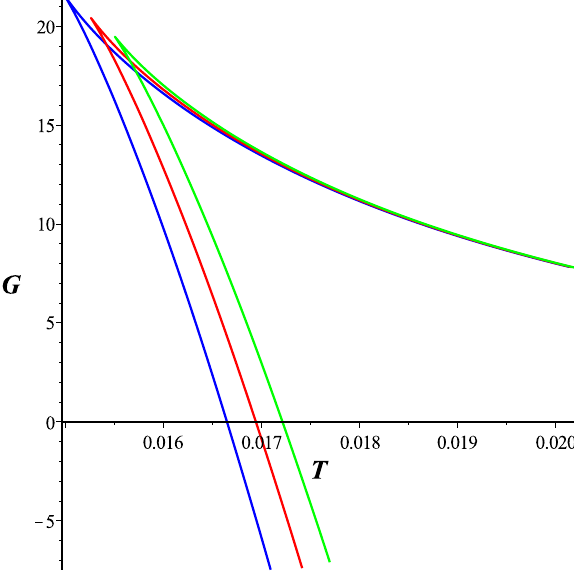
Fig. 1 HP phase transitions for n = 3, d = 10 and Q = 1, p = 0 . 0000045 (blue), p = 0 . 0000050 (red), p = 0 . 0000055 (green). T (horizontal axis) v/s G (vertical